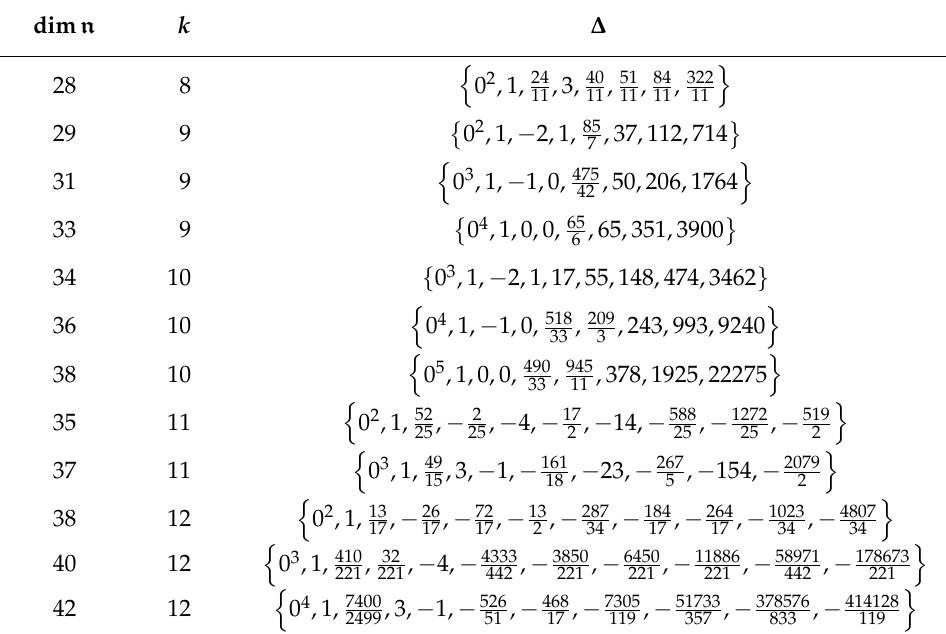
Table 5. Lowest-dimensional solutions for Subcase